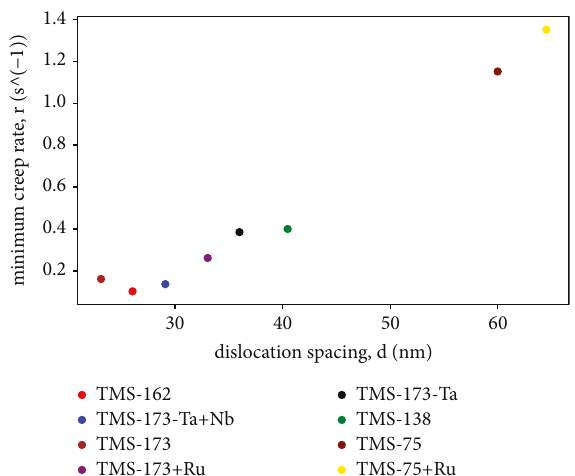
Figure 2: A graphical representation of the change in minimum creep rates with respect to changes in dislocation spacing [22].